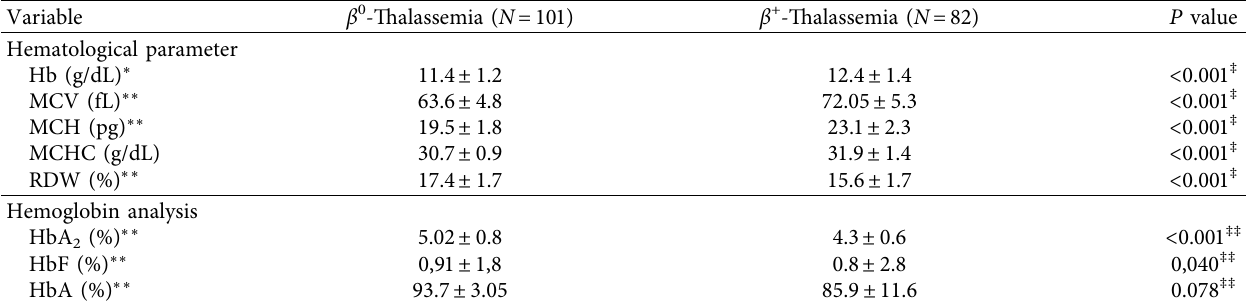
Table 3: Hematological variables among β 0 and β + -thalassemia carrier.